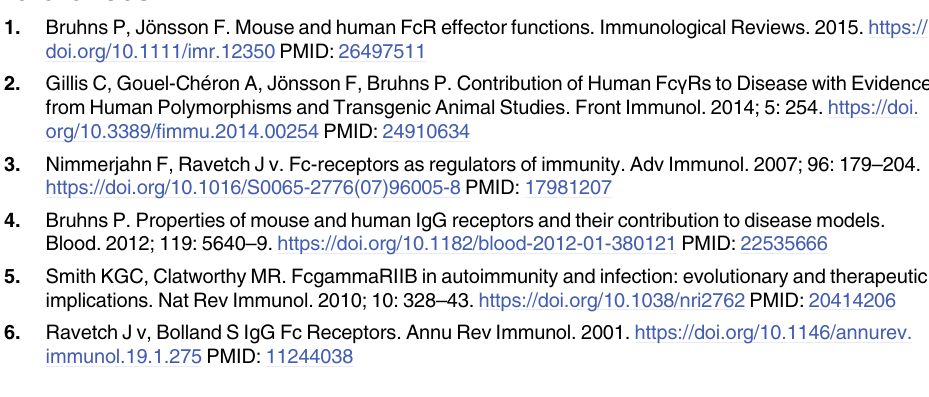
S1 Fig. Analysis of Fc γ RIIIA transfection in HEK293T cells. S2 Fig. Flow cytometric analysis of size, granularity and CD14 expression on THP- 1-CD16A. S3 Fig. Expression of human Fc γ Rs on non-differentiated and PMA-differentiated THP-1 cells. S4 Fig. SDS-PAGE analysis of blocking antibodies